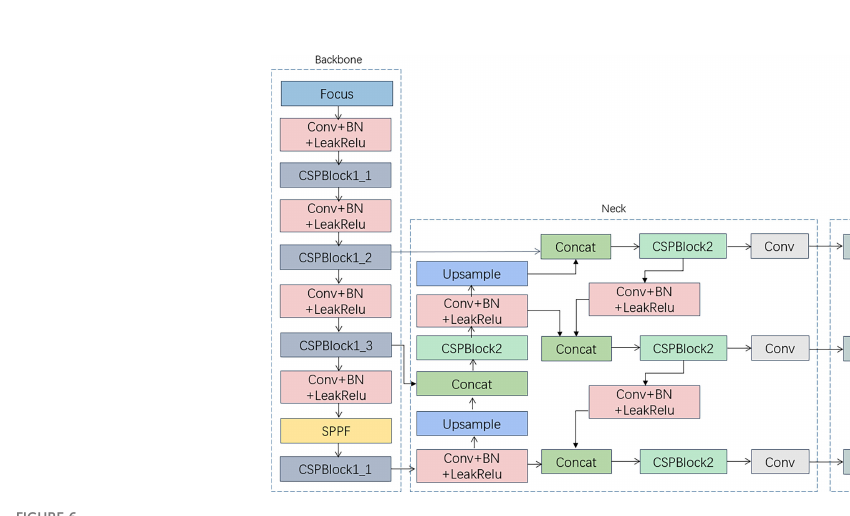
FIGURE 6 YOLOv5